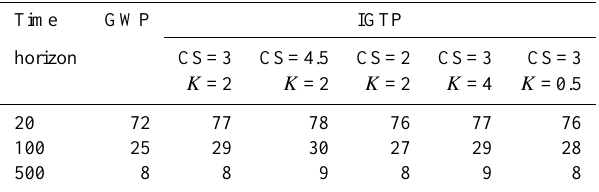
Fig. B1. Modeled and observed historic global mean surface tem- perature change. The historic temperature series is taken from NASA GISS (2012). CS=climate sensitivity (Kelvins per CO 2 equivalent doubling), K =the vertical heat diffusivity (cm 2 s − 1 ). The aerosol forcing is given in Wm − 2 for the year 2005. Historic estimates for the aerosol forcing are scaled linearly with this value. Table C1. GWP and IGTP values for CH 4 . K , the vertical heat diffusivity, is given in cm 2 s − 1 and CS, the climate sensitivity, is given in Kelvins per CO 2 equivalent doubling.